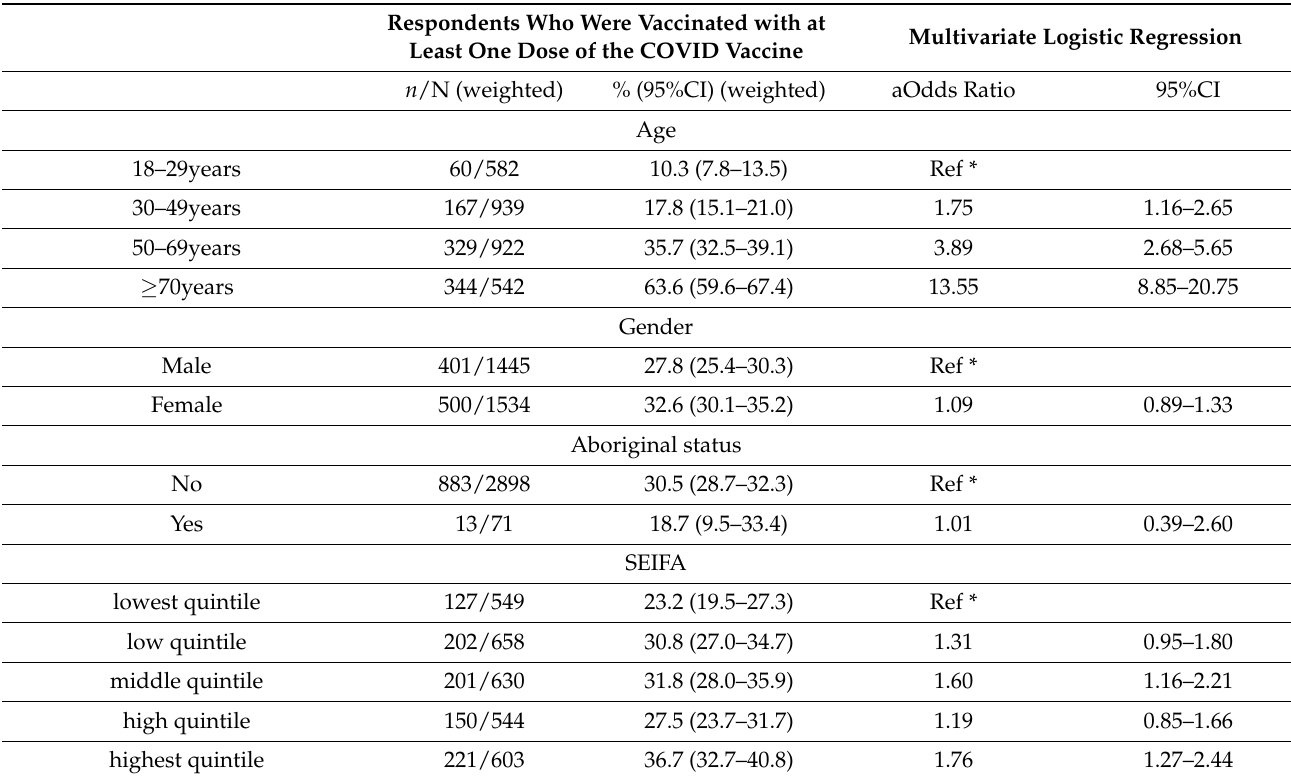
Table 3. Adjusted odds ratios of receiving at least one dose of the COVID